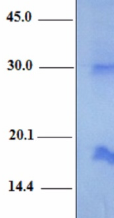
Figure 2. SDS analysis of L. major recombinant H2B. Protein was expressed in BL21 Escherichia coli, then purified by affinity chromatography over Ni-NTA resin and analyzed using SDS-PAGE (15%)